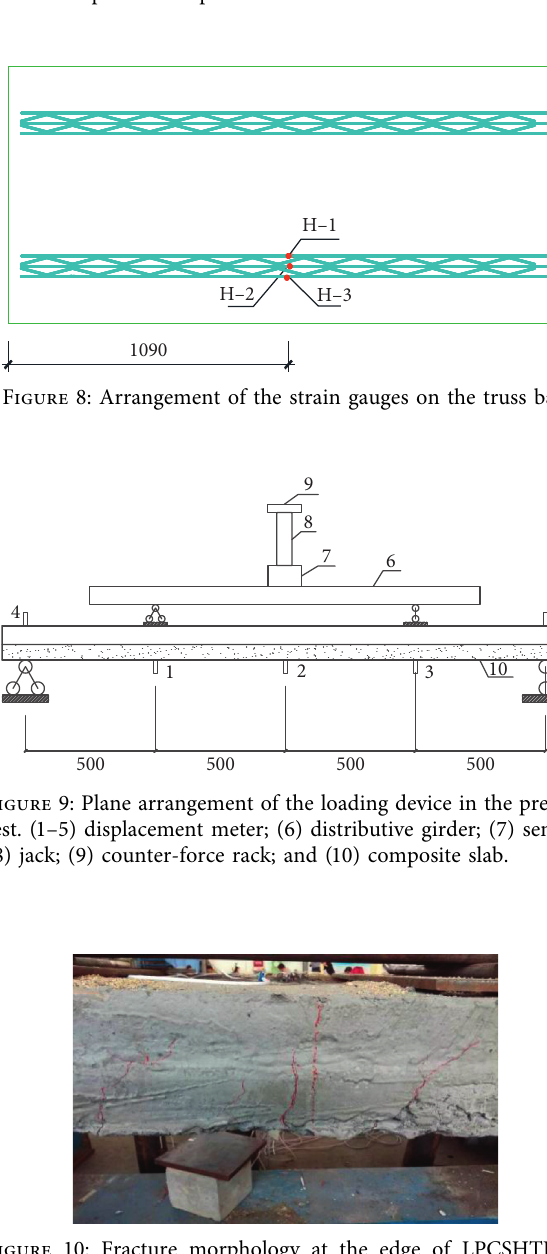
Figure 7: Arrangement plan of the strain gauge on the tensile bars on the composite base plate.